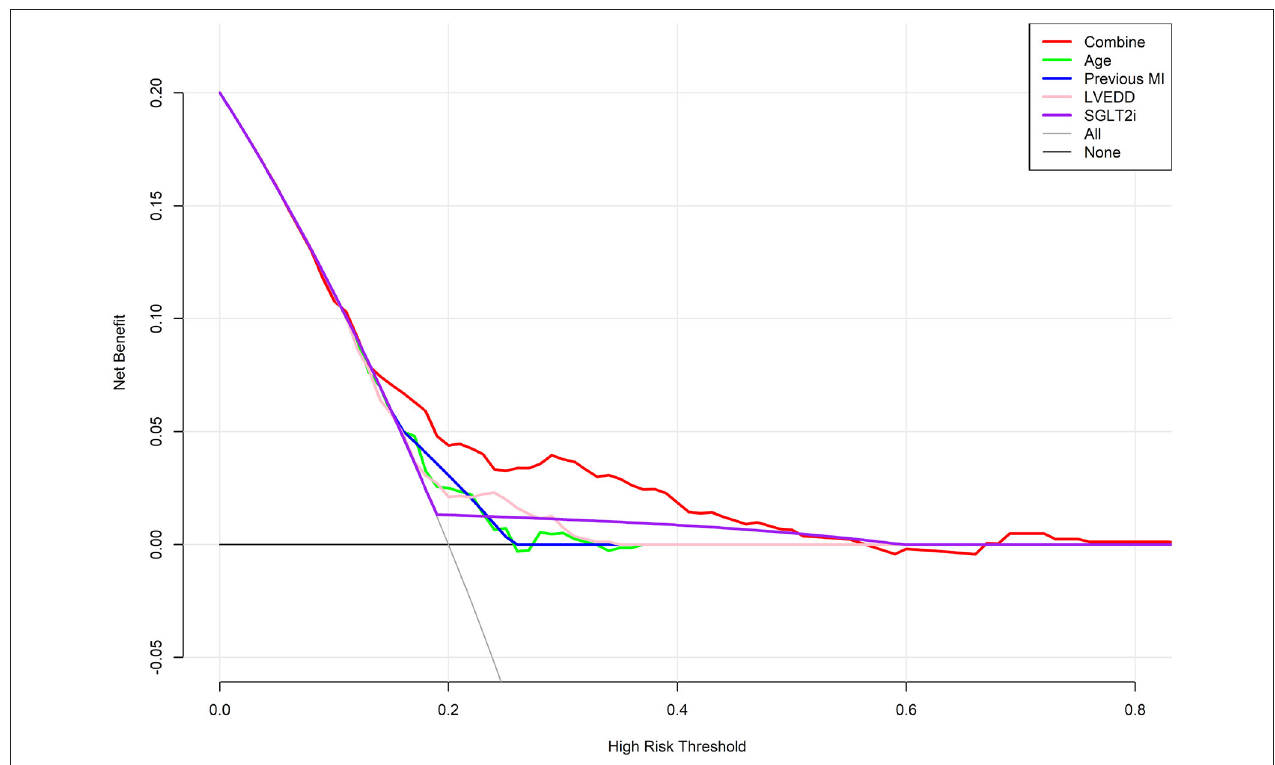
FIGURE 5 | Decision curve analysis for predicting HFiEF. The final complex model outperformed single indices in terms of the net benefit